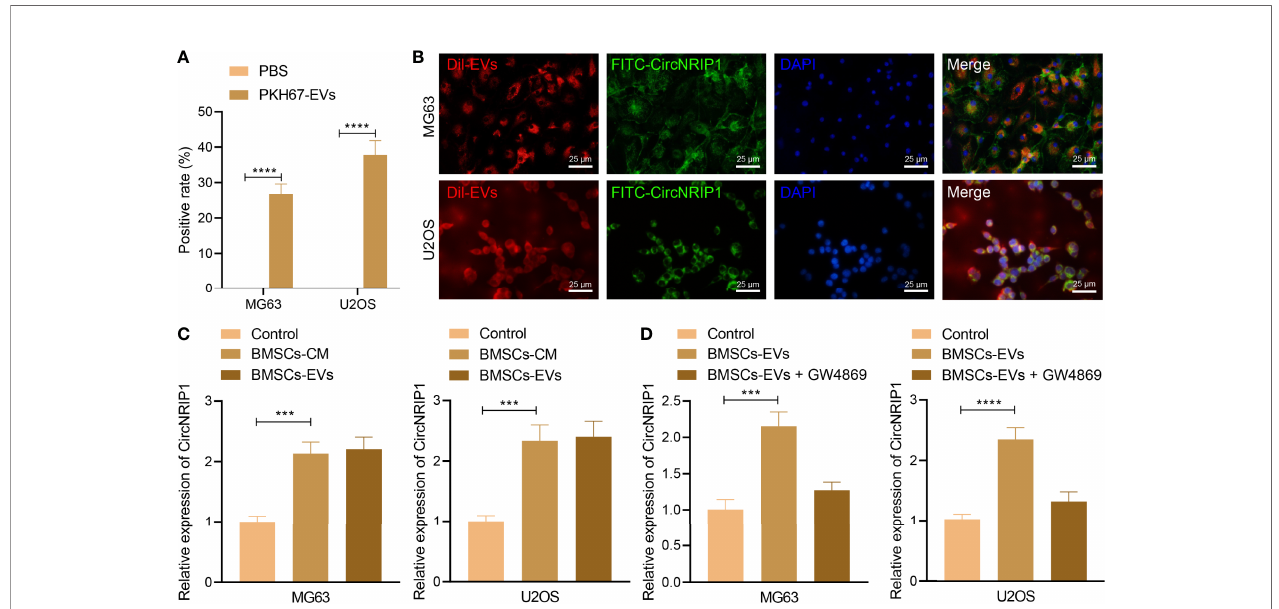
FIGURE 2 | BMSC-EVs encapsulate circNRIP1 and deliver it to the recipient osteosarcoma cells. (A) Uptake of BMSC-derived EVs by osteosarcoma cells (MG63 and U2OS) observed under a confocal microscope, with PBS-treated cells serving as the negative control. (B) Co-localization of FITC-labeled circNRIP1 probe (green) and Dil-labeled EVs (red) in osteosarcoma cells. (C) Expression of circNRIP1 determined by RT-qPCR in the osteosarcoma cells co-cultured with BMSC-CM or BMSC-EVs (the volume of the BMSC-CM co-cultured with the cells was the same with the volume of the CM where BMSC-EVs had been isolated, and the CM used for BMSCs was DMEM). (D) The expression of circNRIP1 in osteosarcoma cells (MG63 and U2OS) measured by RT-qPCR after treatment with BMSC-EVs alone or in combination with EV secretion inhibitor GW4869 (the co-culture was performed in DMEM). *** p < 0.001. **** p < 0.0001. Data are shown as mean ± standard deviation of three technical replicates. Data between two groups were analyzed by unpaired t -test, while those among multiple groups were compared with one-way ANOVA, followed by Tukey ’ s post hoc